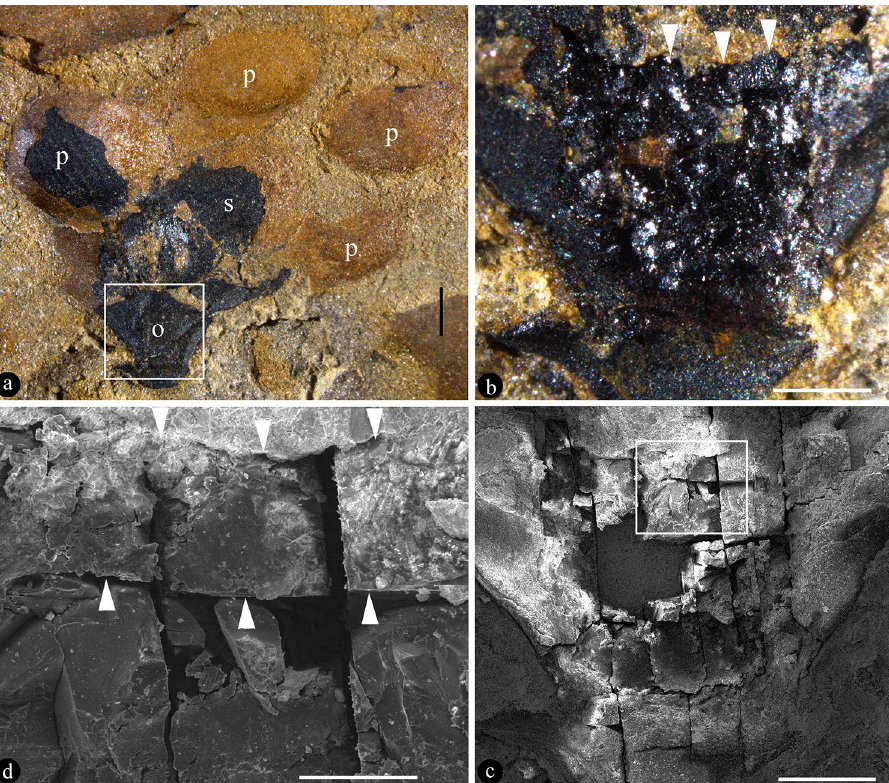
Figure 3. Nanjinganthus dendrostyla . PB22281. ( a ) A coalified laterally compressed flower with ovary (o), sepal (s), and petals (p), embedded in siltstone. Reproduced from Fu et al. 1 . Scale bar = 1 mm. ( b ) Detailed view of the basal portion of the flower shown in ( a ), showing clear border (triangles) between the sediment and ovary roof, exposed through dégagement. Scale bar = 0.5 mm. ( c ) SEM view of the portion shown in ( b ). Scale bar = 0.5 mm. ( d ) Detailed view of the rectangular region in ( c ), showing the ovary roof (between triangles) secluding the ovary from the exterior. Scale bar = 0.1 mm.